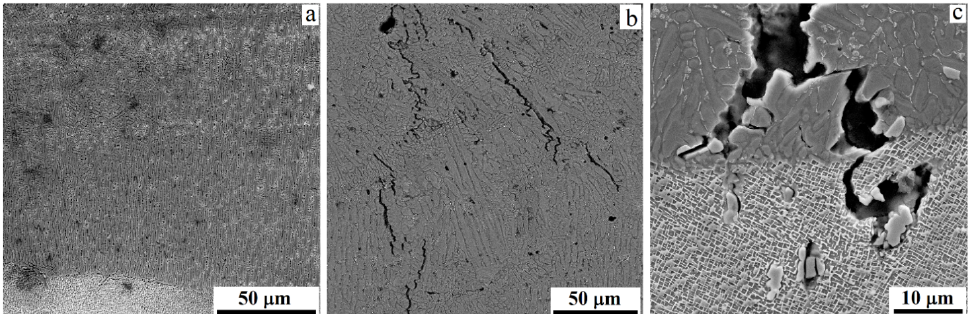
Figure 8. Microstructure of cladding beads: defect-free structure ( a ) and microcracks ( b ) in the weld bead, cracks in the weld bead in the presence of carbide particles ( c